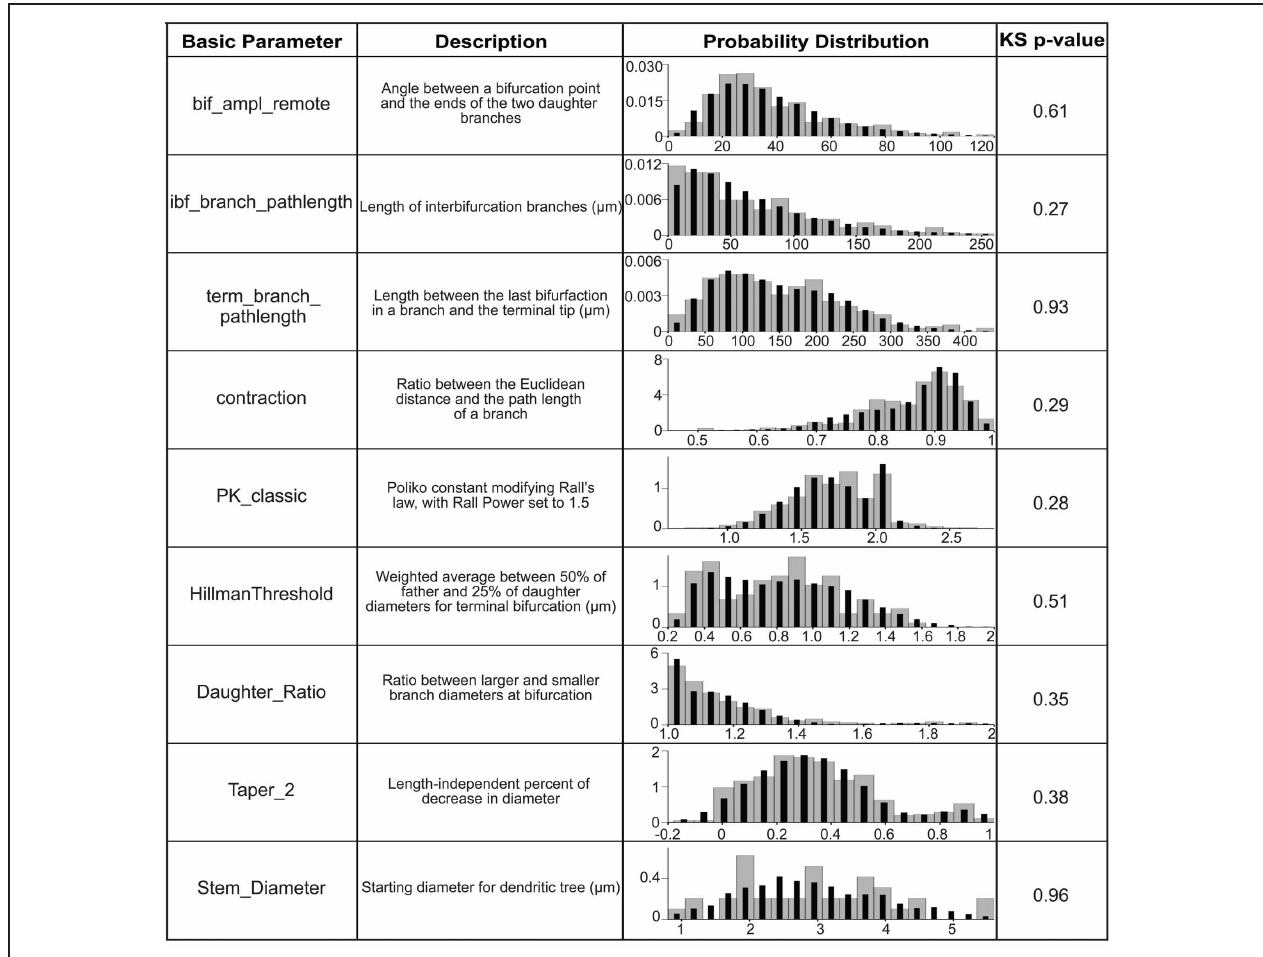
The probability distributions are plotted as probability density versus the basic parameter value for experimental reconstructions (gray bars) and 10,000 generated virtual neurons (black bars), and the p -value for the two-sample Kolmogorov–Smirnov test for the overlap of these distributions is